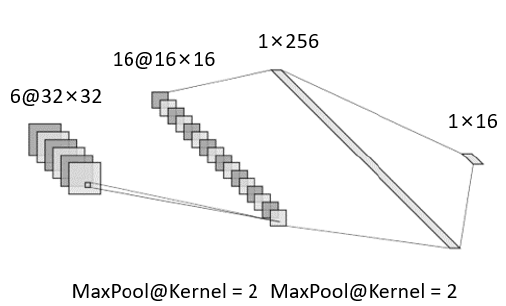
Figure 3. Basic structure of a shallow and small convolutional neural network